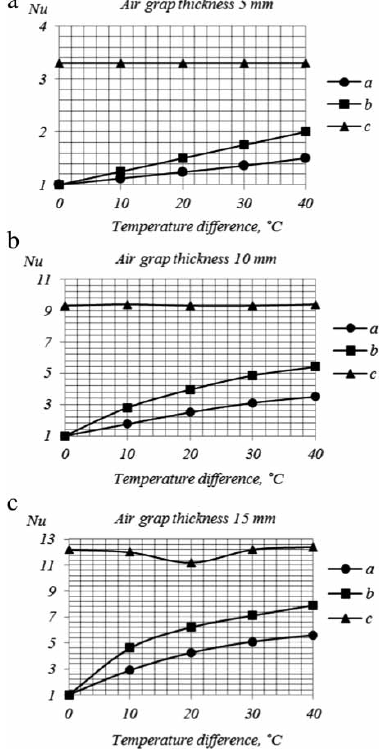
Fig. 2. The dependence of convection on difference in temperature, the thickness of the air gap and its tightness: a (cid:1) small air gap is closed (natural convection); b (cid:1) small air gap is open (natural convection); c (cid:1) small air gap is open (forced convection)